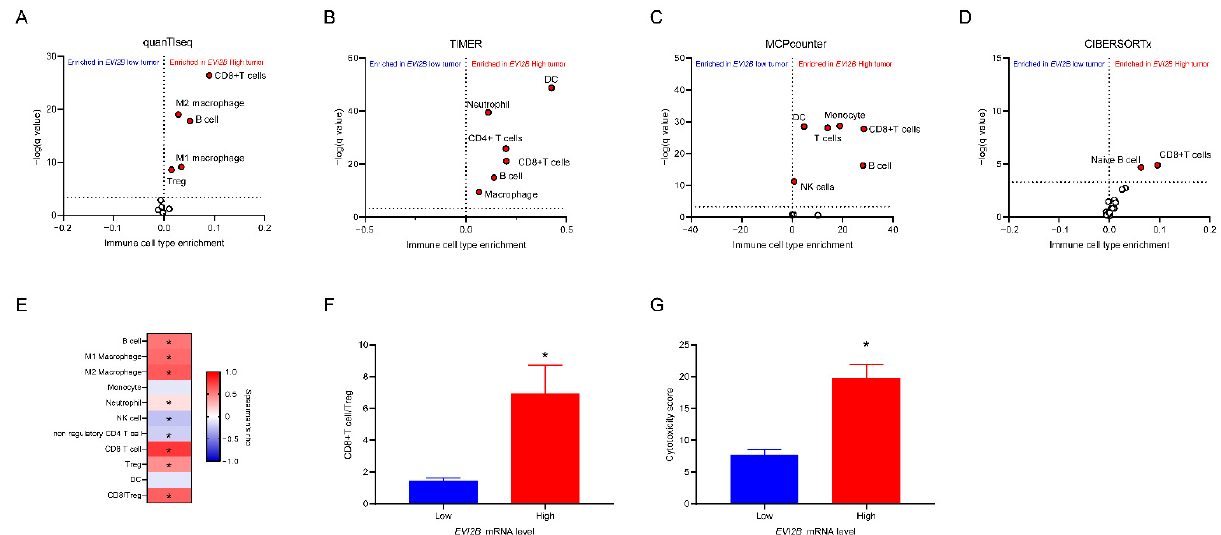
Figure 4. Volcano plots of the estimated TIL fraction in EVI2B high vs. EVI2B low patients: ( A ) quanTIseq; ( B ) TIMER; ( C ) MCPcounter; ( D ) CIBERSORTx. The cell fractions with Q value < 0.05 were considered to be significantly different fractions. ( E ) Spearman correlation of EVI2B gene expression with the TIL fractions estimated by the quanTIseq method, * p < 0.05. ( F – G ) Comparison of the CD8+ T cell/Treg ratio ( F ) and cytotoxicity score predicted by the MCPcounter method ( G ) between EVI2B high vs. EVI2B low patients. * p < 0.05 by Mann–Whitney Tests